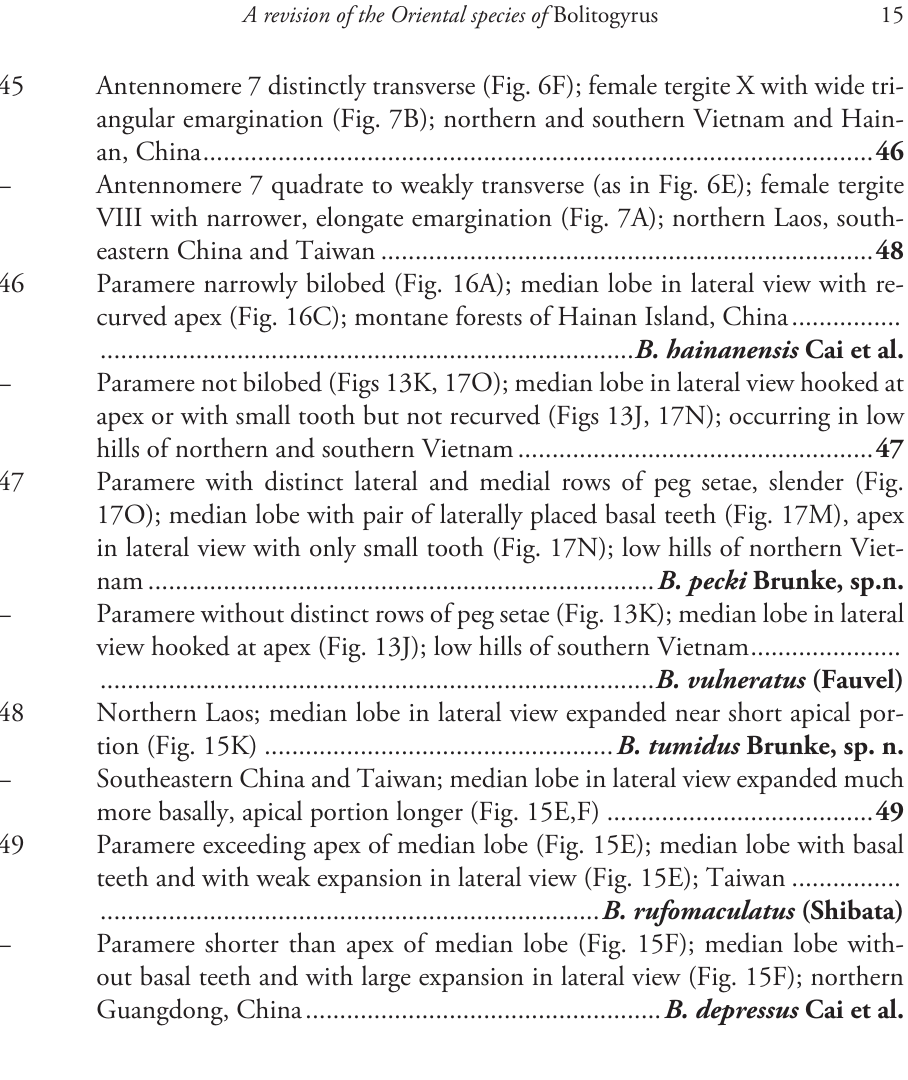
Electus Group The Electus Group ( B. confusus , B. cyanipennis , B. electus , B. huanghaoi , B. kitawakii , B. metallicus , B. nigerrimus , B. nigropolitus and B. uncus ) consists of mostly dark colored